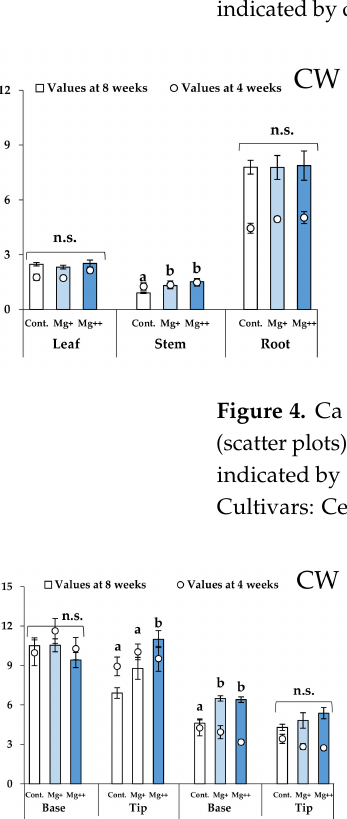
Figure 3. Mg concentrations of leaf, stem, and root in each treatment group and each cultivar at 4 (scatter plots) and 8 weeks (bar graph). Data are means ± SE. Significant differences among means are indicated by different letters. Cultivars: Celeb Wine (CW), Reina White (RW), and Voyage Peach (VP).